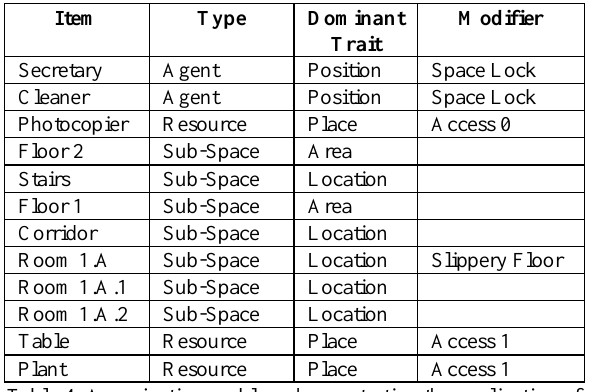
Table 4. A navigation problem demonstrating the application of the framework